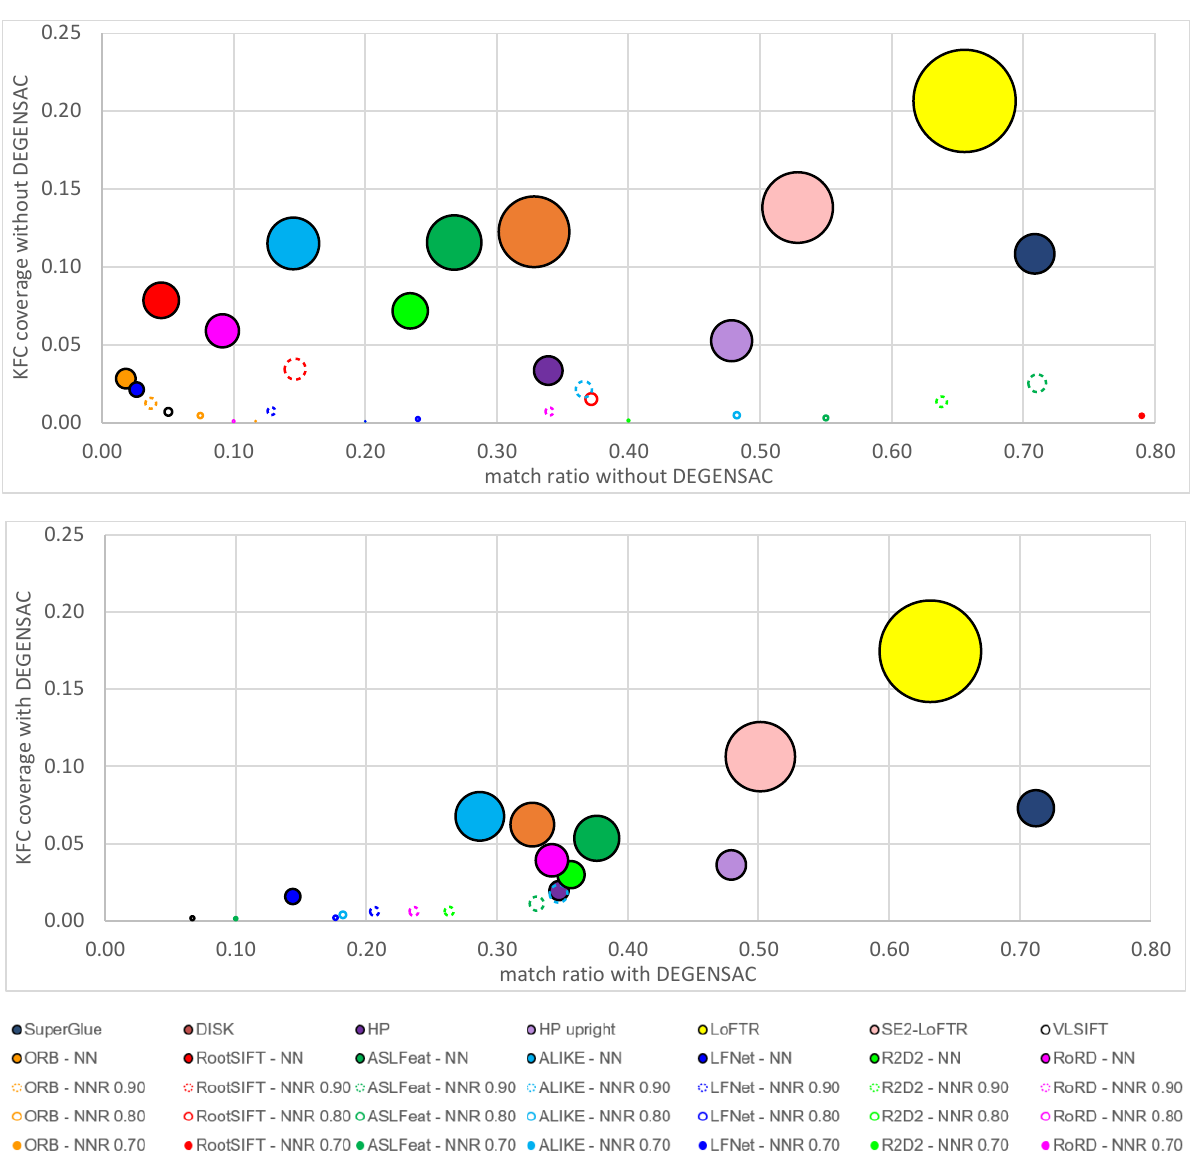
Figure 4 : Scatter plots of the evaluated image matching approaches in terms of their match ratio and KFC coverage without (top row) and with (bottom row) DEGENSAC. The radius of each scatter point indicates the number of correct matches for the associated matching